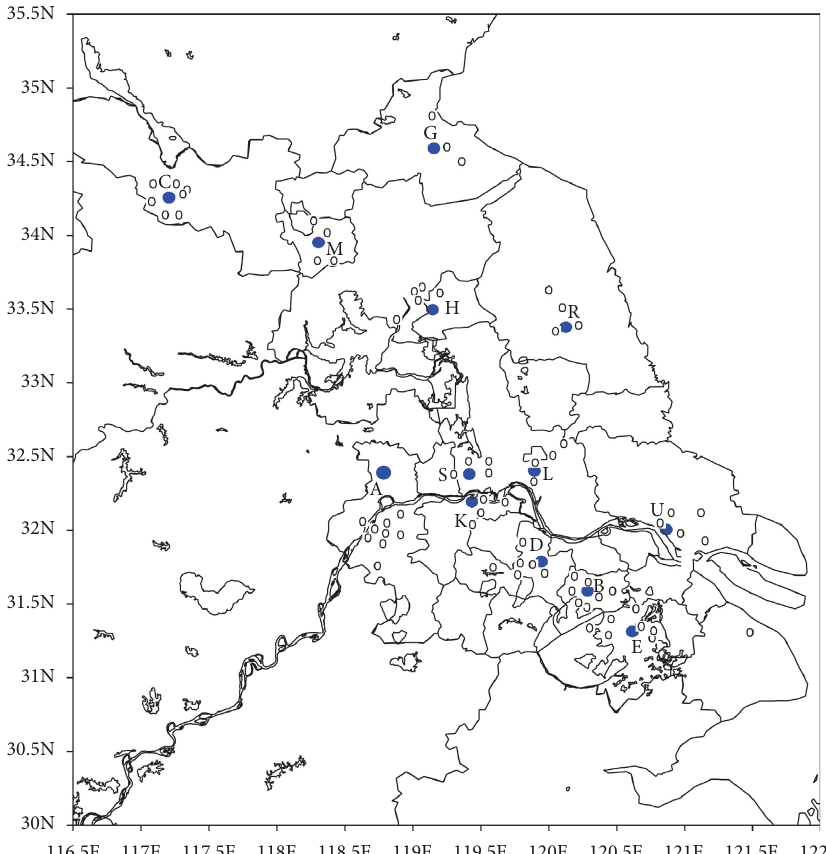
Figure 1: Distribution of 71 air-quality monitoring stations (small white circles) and corresponding city names (blue solid dots) in Jiangsu